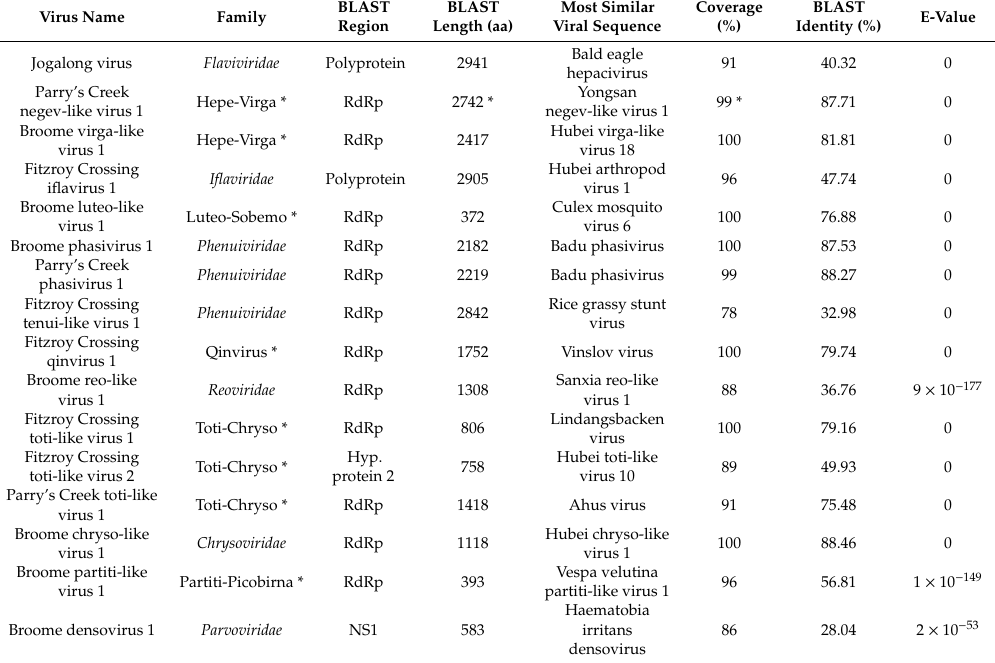
Table 3. Viruses detected from pools of virus-particle purified Culex annulirostris by unbiased high-throughput sequencing (HTS). BLAST—Basic Local Alignment Search